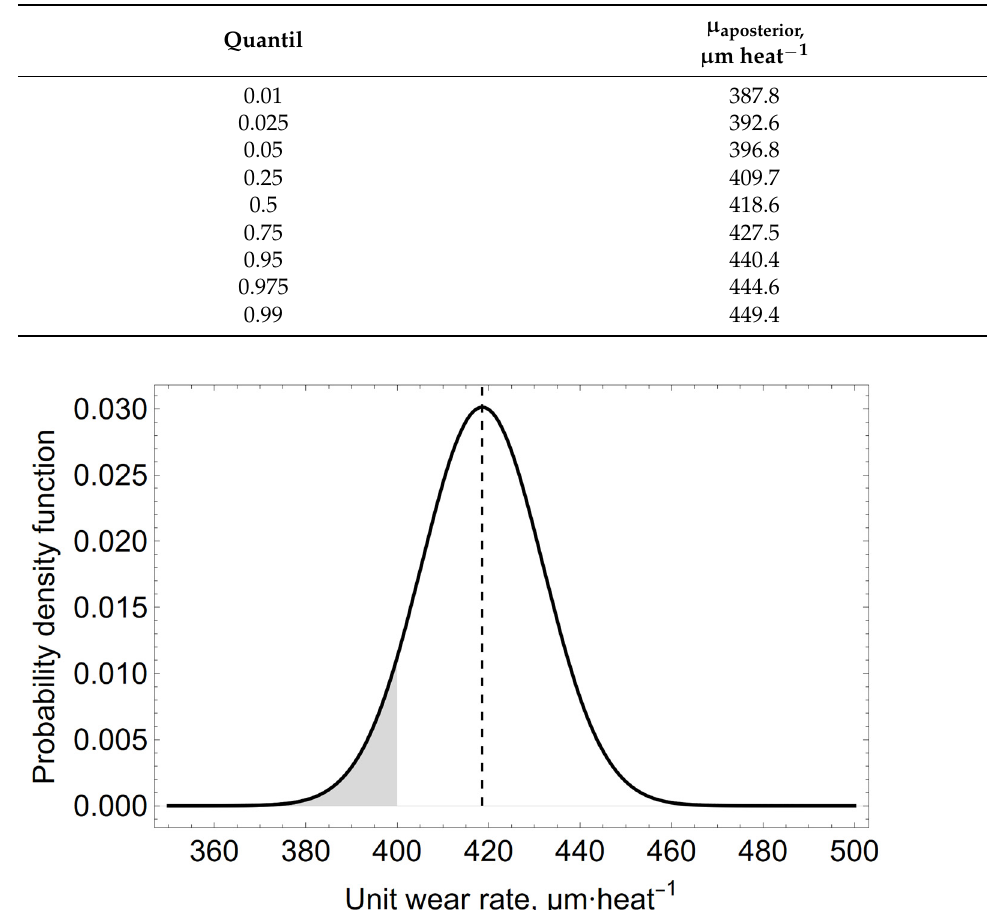
Table 3. Selected quantile values for the predicted unit refractory wear rate in the slag spout zone for a hypothetical 14th measurement of x p = 650 µm heat − 1 , calculated from the a posteriori distribution.